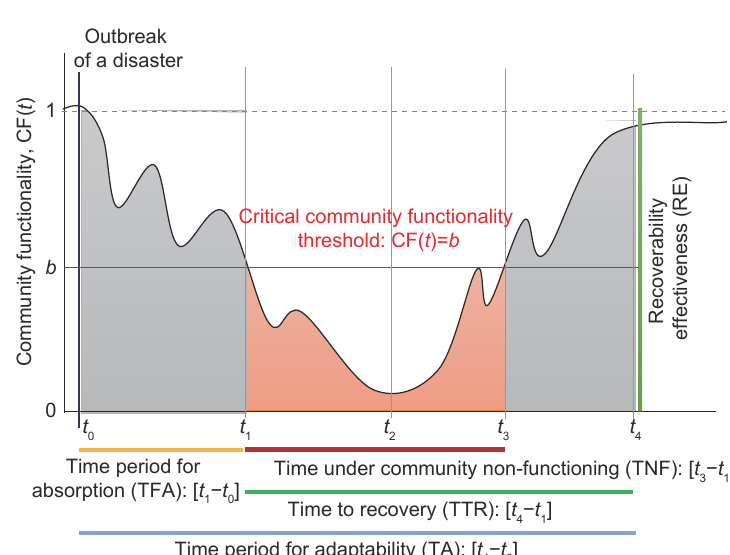
Fig. 2 Evolution of community functionality (CF(t)) from the outbreak of a disaster (e.g., COVID-19) to the full recovery of a